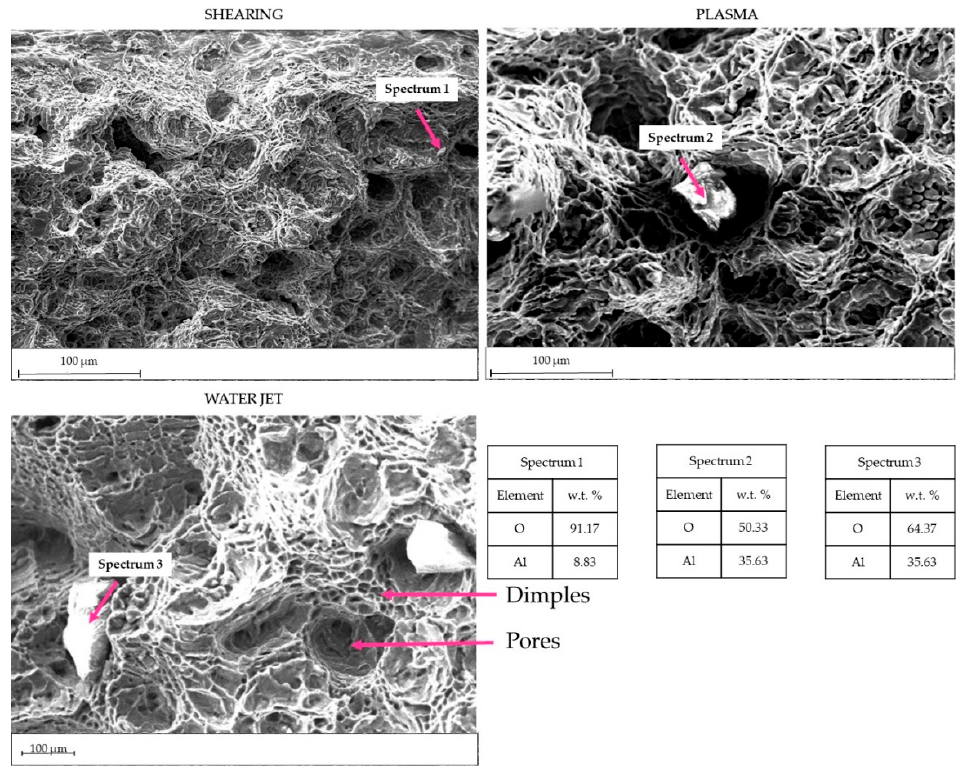
Figure 13. Surface fractures in three TIG-welded tensile specimens. Oxides were detected of variable sizes.